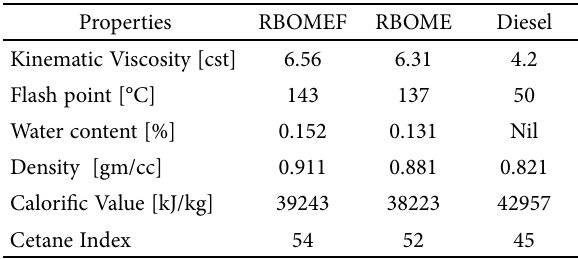
Table 2. Properties of test fuels